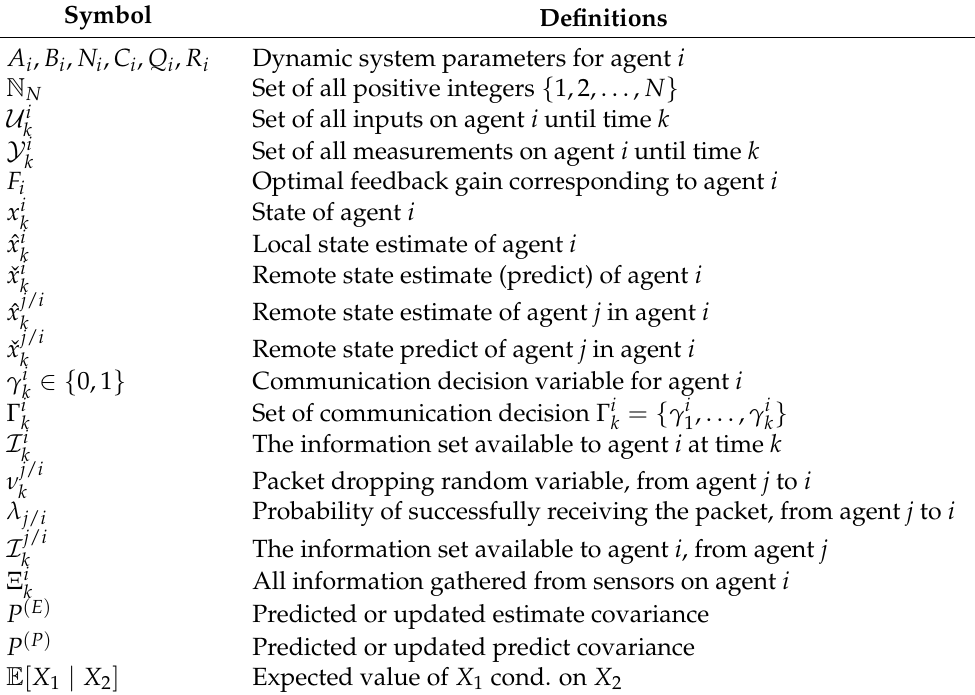
Table 1. Summary of main variables and notations used in this